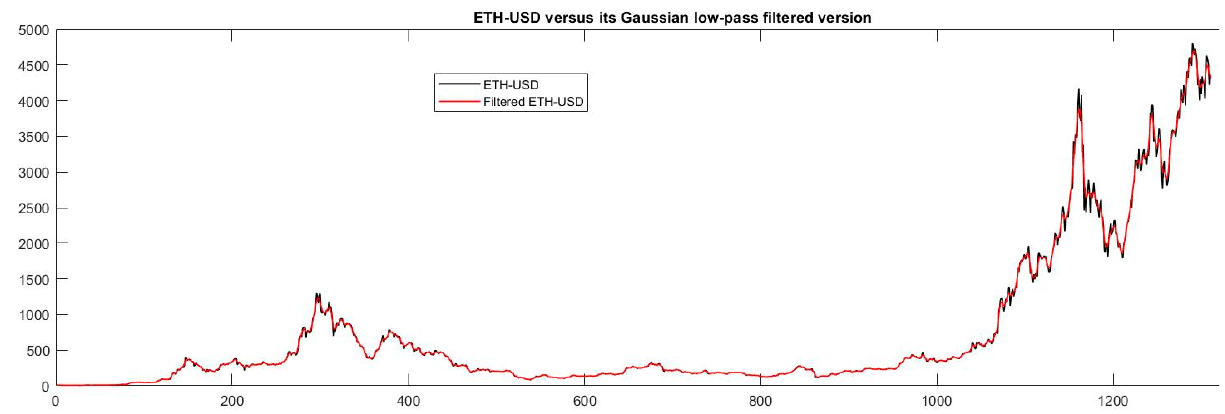
Figure 14. ETH–USD: PACF analysis.